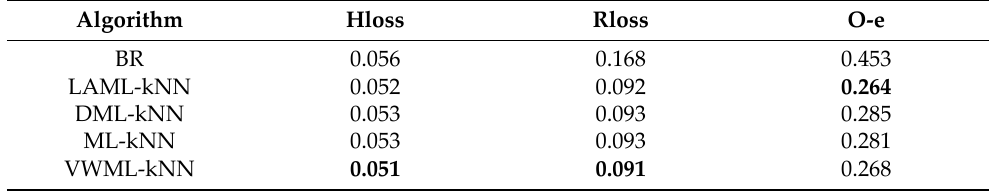
Table 2. Experimental results from different multilabel classification methods on the Enron dataset.